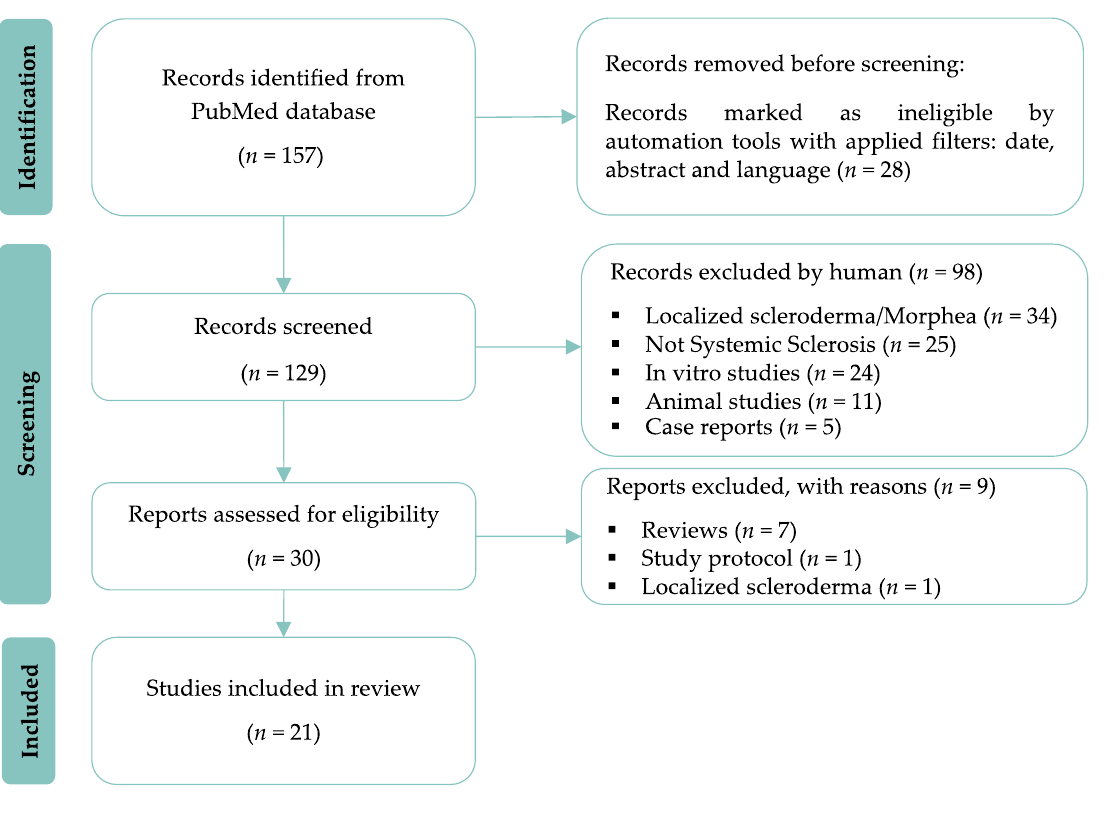
Figure 1. Study attrition flowchart.